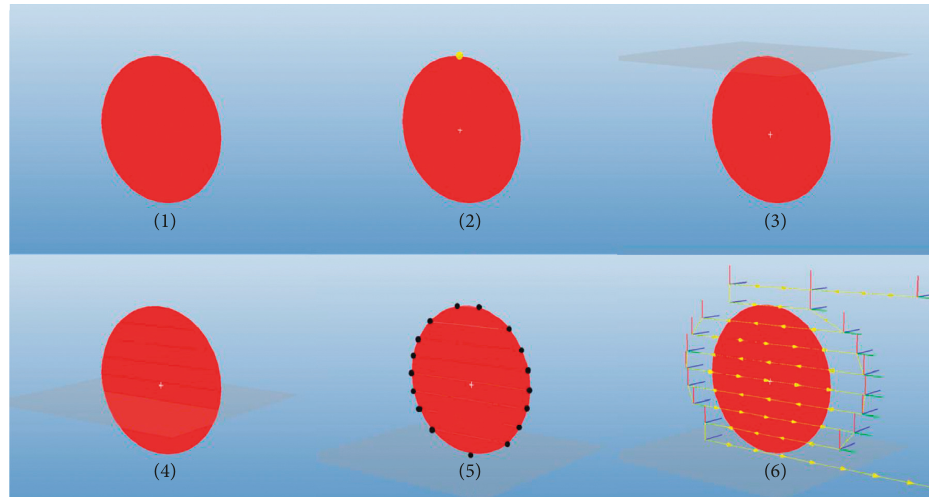
Figure 7: Autogeneration on a curved-edge polygon profile.